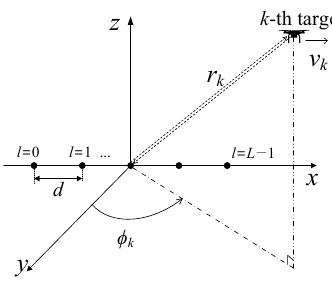
Figure 1. Radar system scenario with the two-element sectoral horn antenna array.